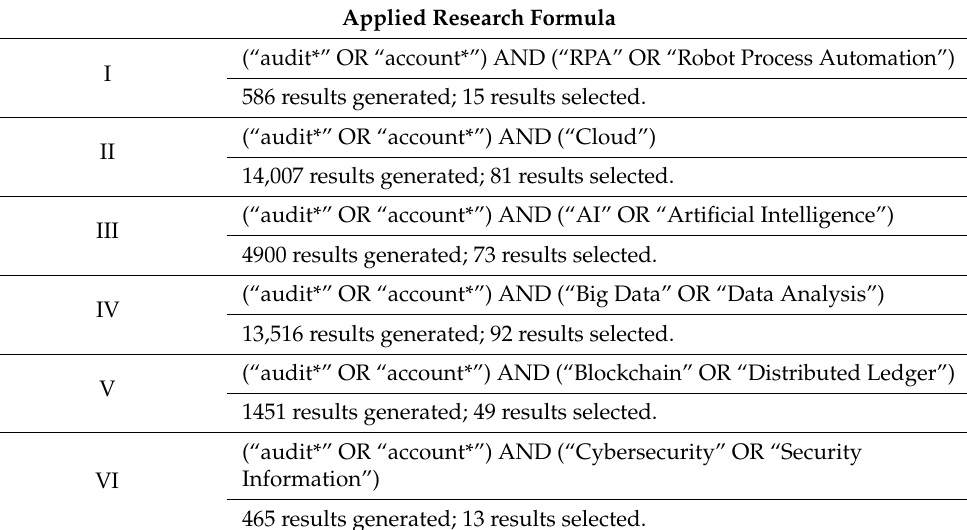
Table 1. Applied research formula and generated results. (Source: authors’